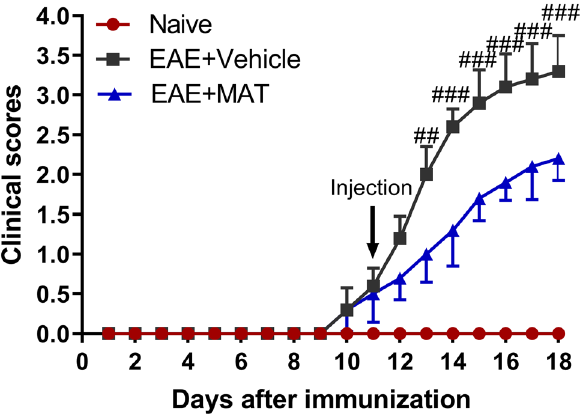
Figure 1. MAT ameliorated clinical signs of EAE. Wistar rats were immunized with spinal cord homogenate of guinea pig in CFA. Rats received MAT (250 mg/kg in 1 ml normal saline daily, i.p.) at onset of clinical signs of EAE until day 18 p.i., and control rats received the same volume of saline. All rats were evaluated daily for clinical scores of EAE in a blinded fashion from day 0 to 18 p.i. Clinical score—time graph of every group based on a 0–5 scale. Data represent mean ± SD (n = 10 rats per group). Clinical EAE scores were analyzed at single time points between treated and untreated rats using GraphPad Prism 5.0; (GraphPad Software). ## P < 0.01, ### P < 0.001, comparisons between vehicle- and MAT-treated